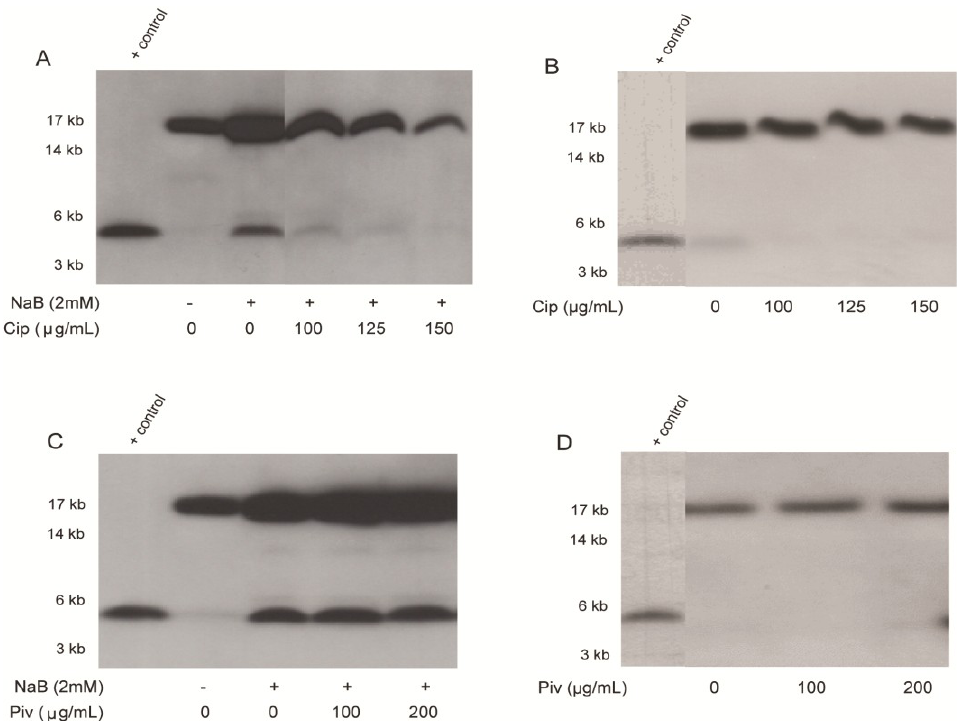
Figure 2. Effect of ciprofloxacin and pivmecillinam on LL-37 peptide and hCAP-18 in HT-29 cell supernatants. HT-29 cells were stimulated for 24 h with NaB and/or ciprofloxacin ( A , B ), with NaB and/or pivmecillinam; ( C , D ). Release of LL-37 peptide (lower band) and its proform hCAP-18 (upper band) in culture supernatants was detected by Western blot analysis. Representative pictures are given. Synthetic LL-37 peptide was included as positive control. The blot data in panel 2A are composites of two portions of a larger data set, while data of panels 2B and 2D are composites of two experiments. NaB: sodium butyrate; Cip: ciprofloxacin; Piv: